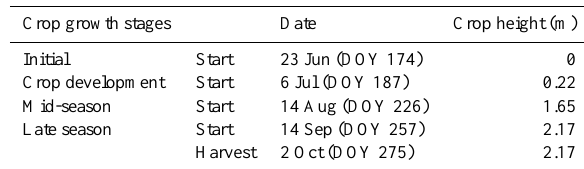
Table 1. Crop growth stages and crop height for maize. DOY, day of the